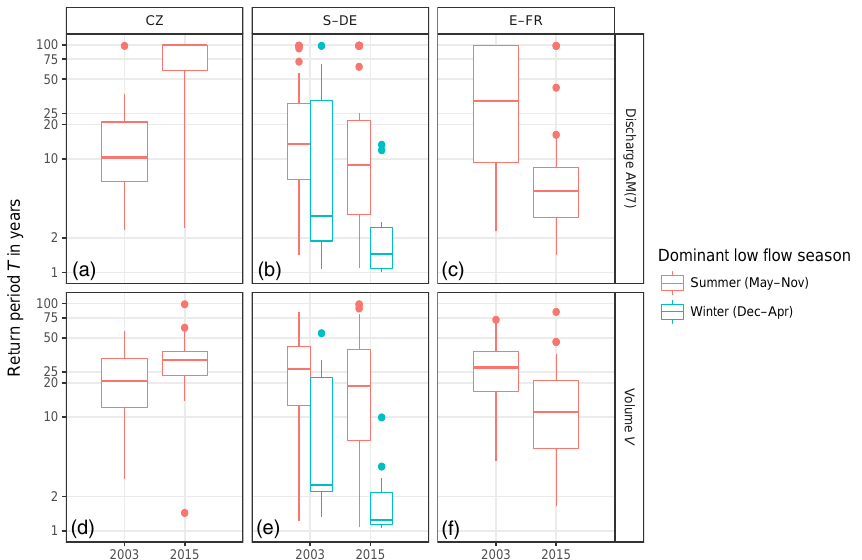
Figure 2. Regional distribution of return period T (in years) of low flow discharge AM(7) (a–c) and deficit volume V (d–f) for the Czech Republic (a, d) , southern Germany (b, e) , and eastern France (c, f) (return periods > 100 years not shown). For southern Germany, the blue box plots represent alpine catchments with a winter low flow regime (mean day of occurrence of AM(7) between December and April). Boxes refer to upper quartile ( T 75 ), median ( T med ), and lower quartile ( T 25 ) of the return period, dots represent the maximum range of outliers. Return period of about 2–10 years represents mild drought conditions, 10–50 years moderate conditions, 50-100 years severe conditions, and > 100 years extreme